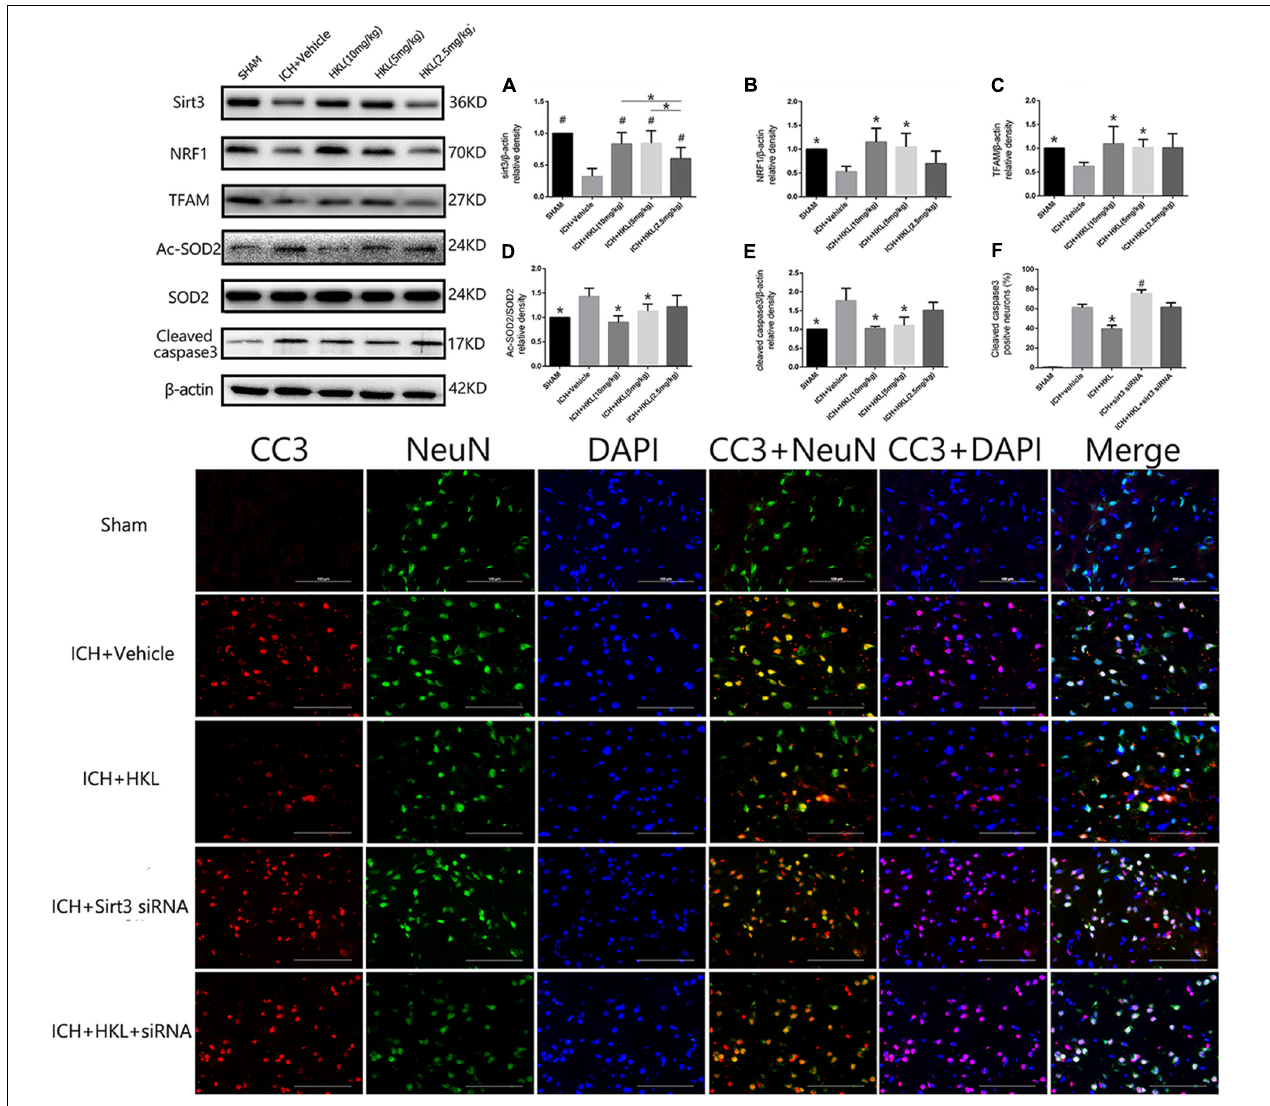
FIGURE 3 | HKL mediated the expression of sirt3 and its downstream signaling molecules after hyperglycemic ICH. (A) Sirt3 protein expression was significantly enhanced by HKL in a dose-dependent manner. # P < 0.05 versus ICH + vehicle group, ∗ P < 0.05 ( n = 6 in each group). (B) NRF1 expression, ∗ P < 0.05 versus ICH + vehicle group ( n = 6 in each group). (C) TFAM expression, ∗ P < 0.05 versus ICH + vehicle group ( n = 6 in each group). (D) Ac-SOD2/SOD2 ratio ( Ac-SOD2 , acetylated SOD2), ∗ P < 0.05 versus ICH + vehicle group ( n = 6 in each group). (E) Cleaved caspase3 expression, ∗ P < 0.05 versus ICH + vehicle group ( n = 6 in each group). (F) Representative co-labeling cleaved-caspase3/NeuN images of ipsilateral basal ganglia. Quantification of cleaved caspase3-positive neurons (% = cleaved caspase3-positive neurons/total neurons), ∗ P and # P < 0.05 versus the rest groups ( n = 6 in each group). Scale bars: 100 µ